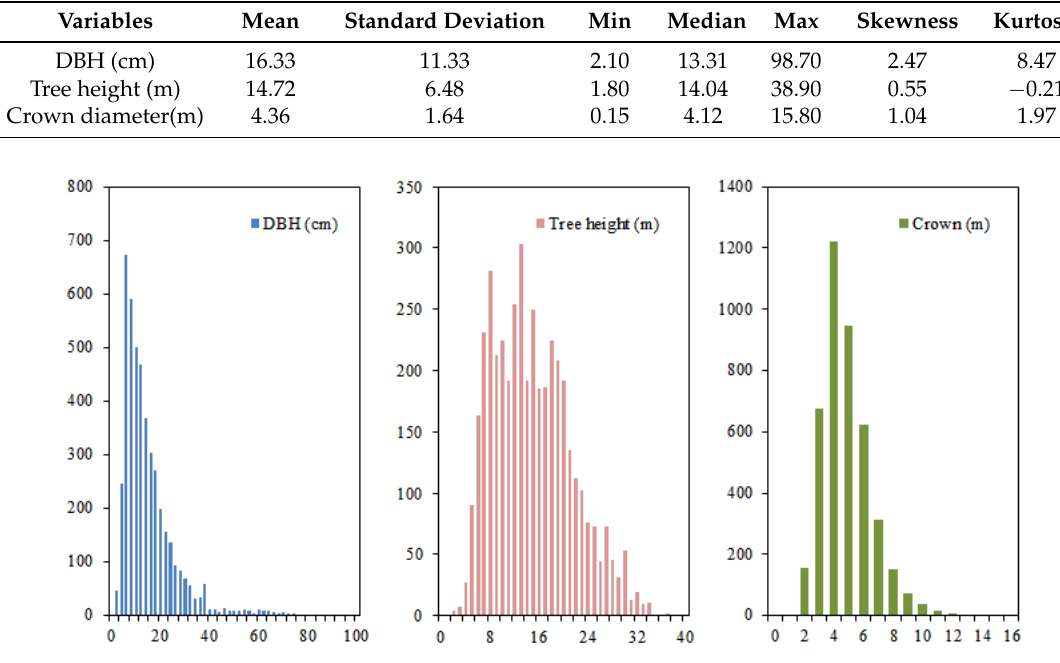
Figure 2. Histogram for recorded DBH, tree height and crown diameter variables.